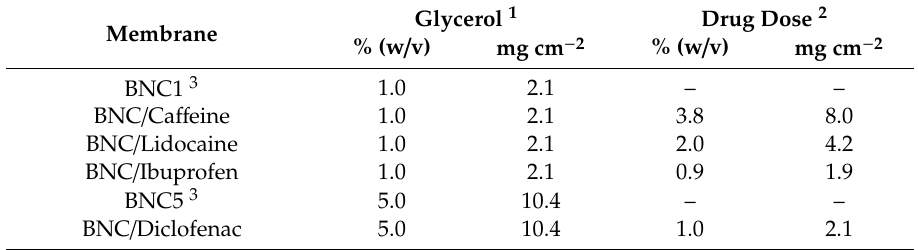
Table 1. Identification of the API-loaded BNC membranes with the respective drug